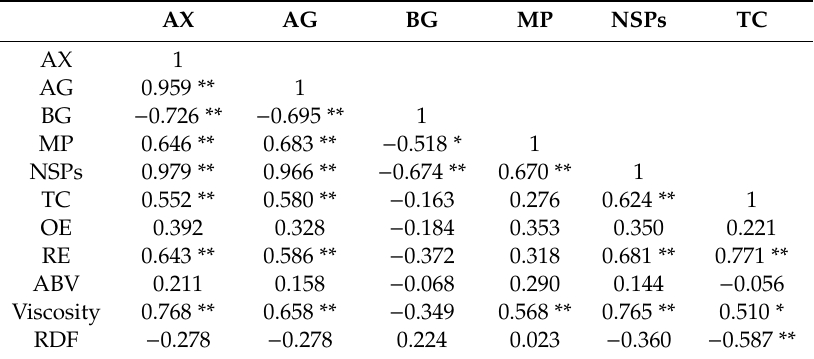
Table 5. Pearson correlation coe ffi cient matrix of variables for all beer samples. AX AG BG MP NSPs